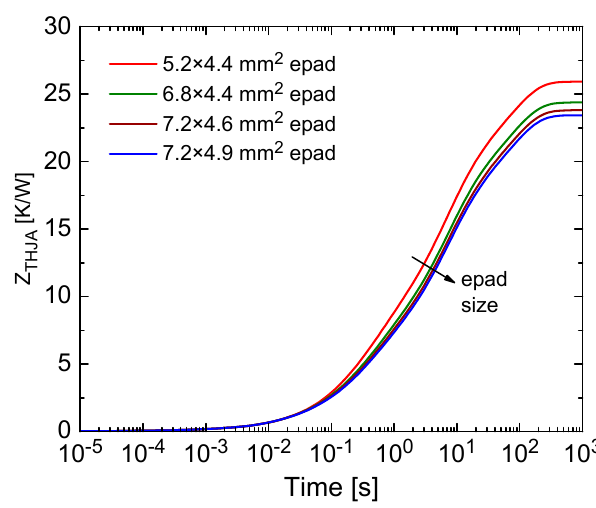
Figure 10. Thermal impedance Z THJA of a 10.3 × 7.5 mm 2 PowerSSO-36 L with a 4.09 × 3.17 mm 2 die for four different epad sizes.